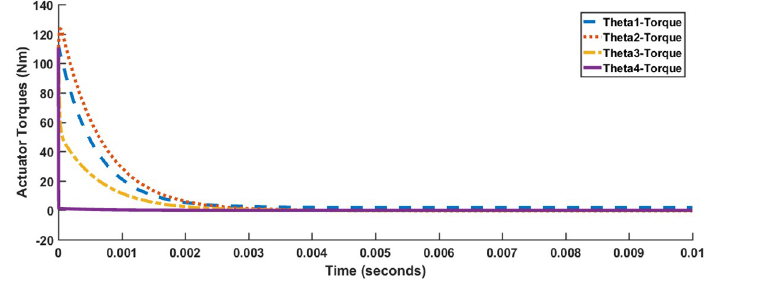
Fig 5. Actuator torques for LQR, Case